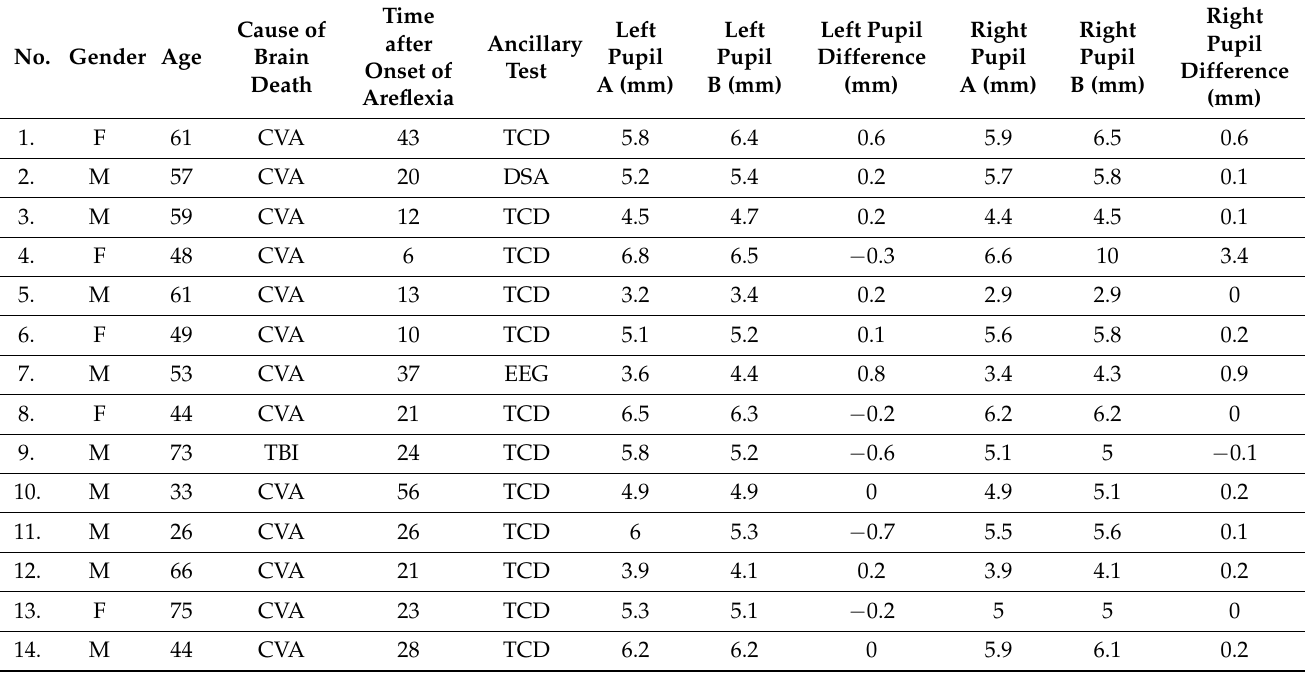
Table 1. Diameter of pupils (mm): A—before head flexion, B—after head flexion, TBI—trauma brain injury, CVA—cerebrovascular, TCD—transcranial Doppler, EEG—electroencephalography, DSA—digital subtraction angiography, F—female, M—male. All pupil size measurements are provided in millimeters